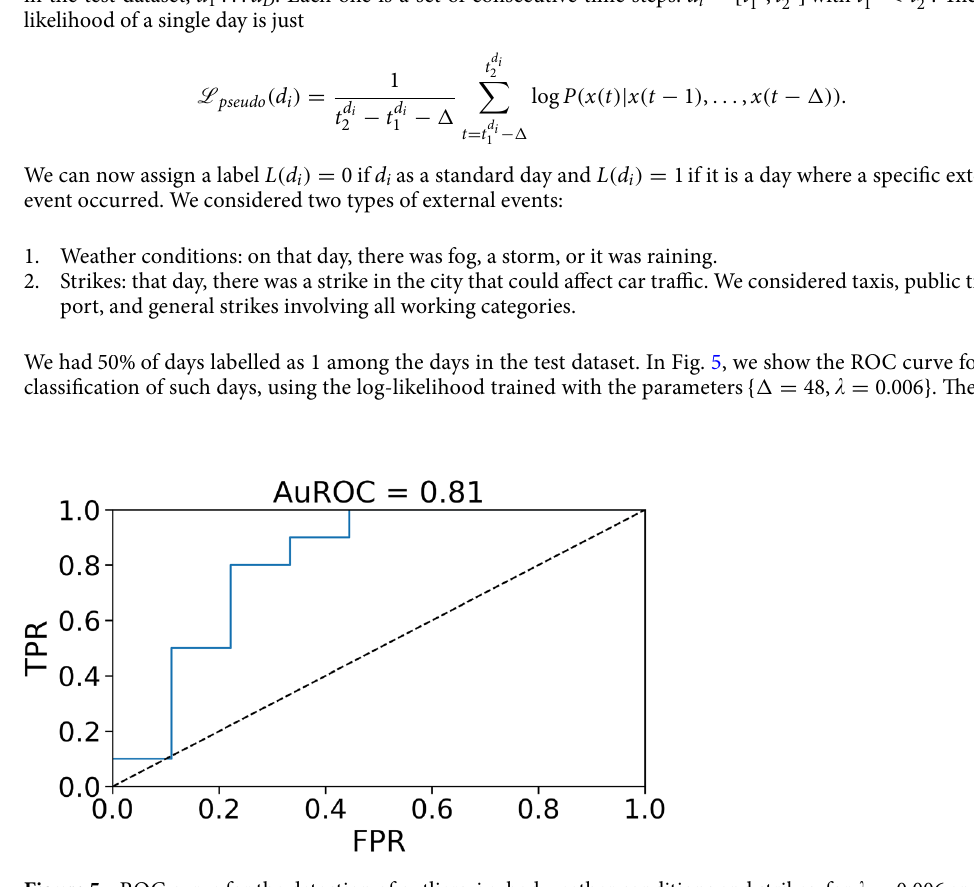
Figure 5. ROC curve for the detection of outliers, i.e. bad weather conditions and strikes, for (cid:31) = 0.006 and (cid:31) = 48